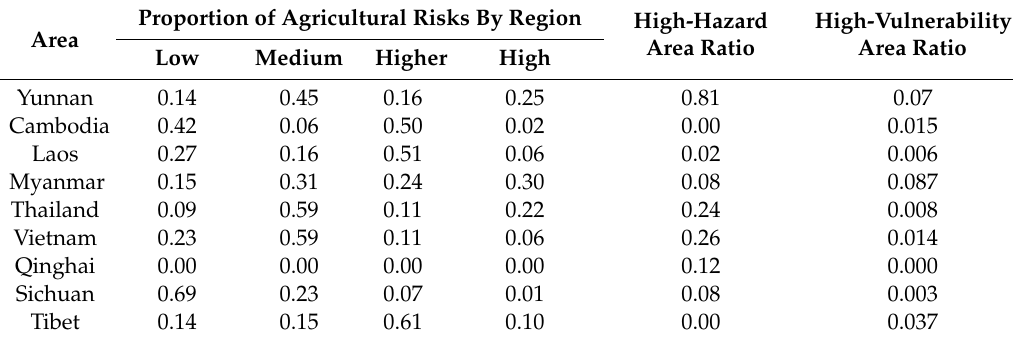
Table 7. Regional di ff erences of drought risk in the